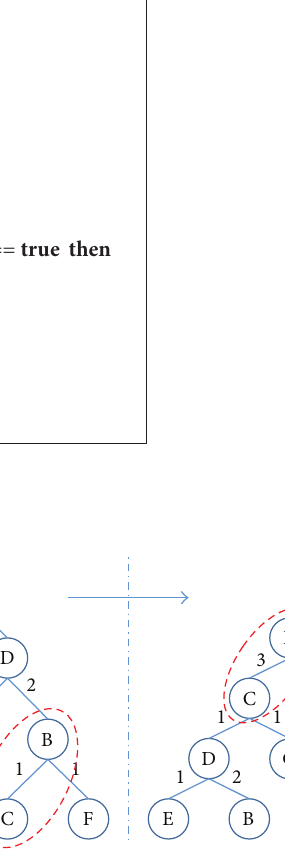
Figure 2: Data structure of a node on the sequence-tree. Figure 3: Branch shifting. The two pairs of nodes B-C marked with dotted circles on the left tree should be merged together, and their branch weights should be added up too. The right tree is the result of this branch